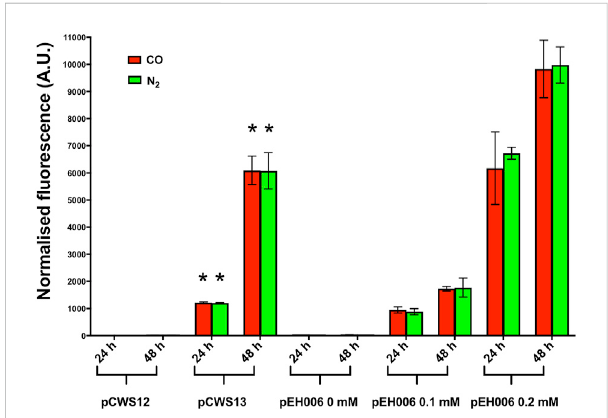
FIGURE 4 RFP expression of C. necator H16 containing either pCWS12, pCWS13 or pEH006. Cultures were grown at 30 ° C in 20 mL F-MM contained in 150 mL serum bottles under a 2 bar atm of 50% CO/50% air (v/v) (redbars)or 50% N 2 /50% air (v/v) (green bars).Expression of the rfp gene was monitored after 24 h and 48 h by determining RFP fl uorescence. pCWS12 contained the wild type upstream region of cydA2B2 linked to rfp ; pCWS13 contained the mutated upstream region of cydA2B2 linked to rfp and RFP expression of pEH006 was inducedwiththeindicatedarabinoseconcentrationsof0 mM,0.1 mM and 0.2 mM. Average normalised fl uorescence is given for each time point. Error bars represent standard deviations from the mean for three biological replicates. There was no signi fi cant difference between samples taken from CO or N 2 grown cultures for C. necator pCWS12 (24 h, p = 0.98; 48 h, p = 0.64) and C. necator pCWS13 (24 h, p = 0.56; 48 h, p = 0.97). There was a signi fi cant difference (indicated by an asterisk) between C. necator pCWS13 and C. necator pCWS12 in the presence of CO and compared to the N 2 control ( p < 0.00001 for all time